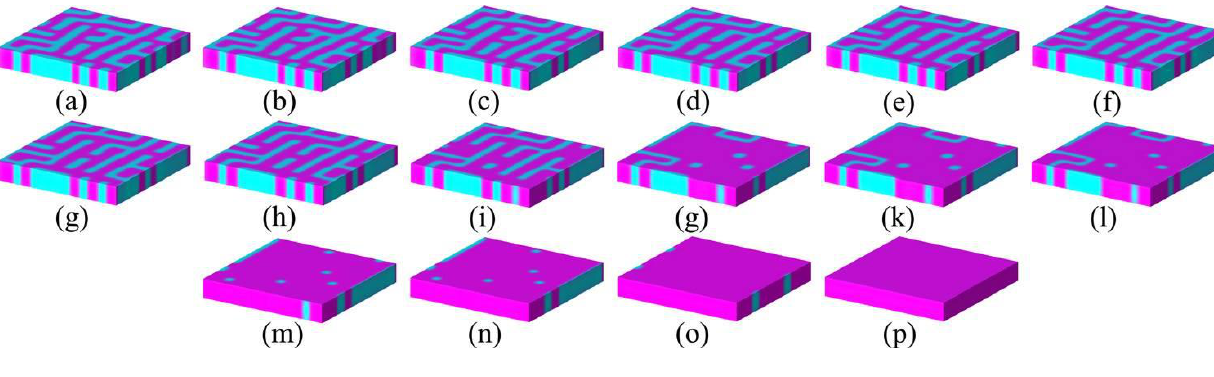
Figure 6. Domain evolution of the PbTiO 3 thin film, i.e. , ( a )–( p ), controlled by the ionic charge density due to oxidizing atmosphere from 0.005 C/m 2 to 0.0425 C/m 2 with an interval 0.0025 C/m 2 . (Reprinted with permission from [297]. Copyright 2011, AIP Publishing